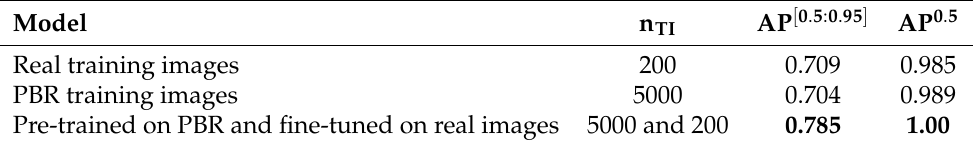
Table 7. Using real training data.